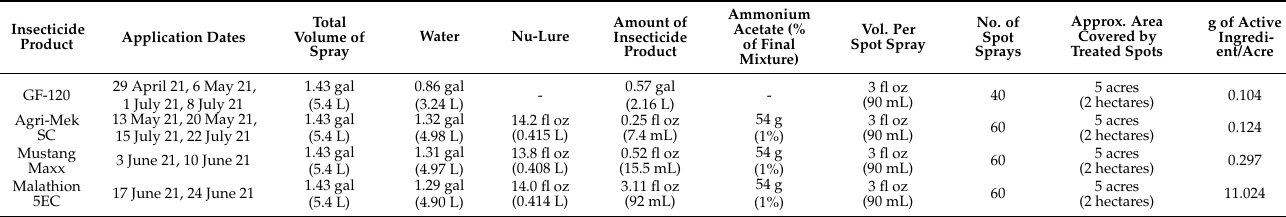
Table 4. The amount of each insecticide (mixed with Nu-Lure Insect Bait) applied to roosting plants of Zeugodacus cucurbitae in the perimeter of cucurbit crop fields per application during the insecticide rotation trial on the Maui commercial farm. The approximate area covered by the treated spots is the area of cucurbit crops inside the surrounding treated roosting